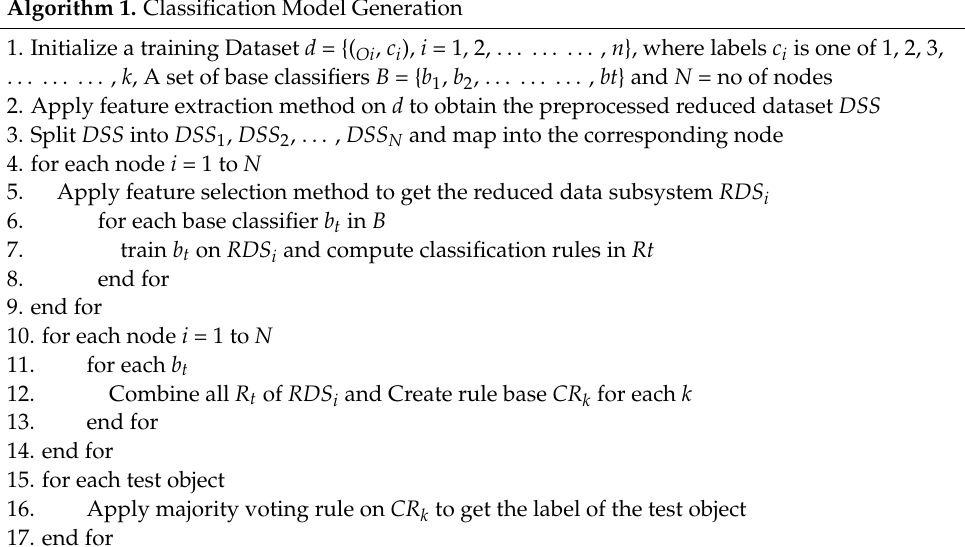
Algorithm 1. Classification Model